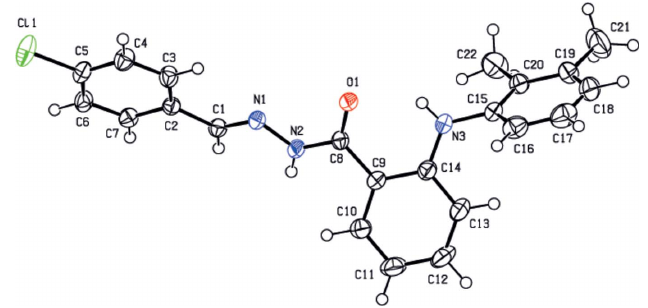
Figure 1 The structure of the title compound, with displacement ellipsoids for non- H atoms drawn at the 50% probability